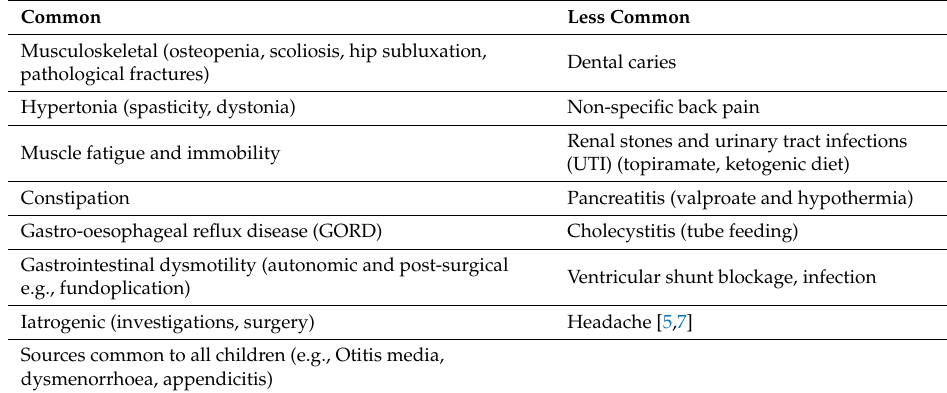
Table 2. Sources of nociceptive pain in children with severe neurological impairment